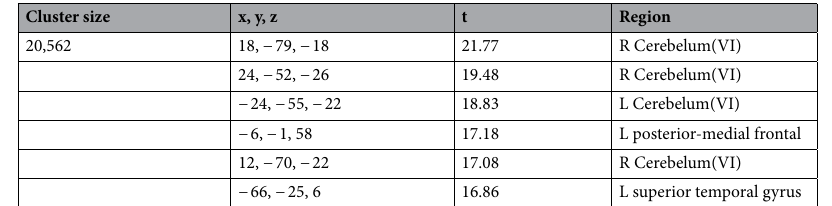
Table 1. The task-related activations. Contrasts were significant at a voxel level threshold of p < .001 combined with an FWE correction of p < .05 for cluster size. MNI coordinates and t-scores are from the peak voxel of a cluster (listed 6